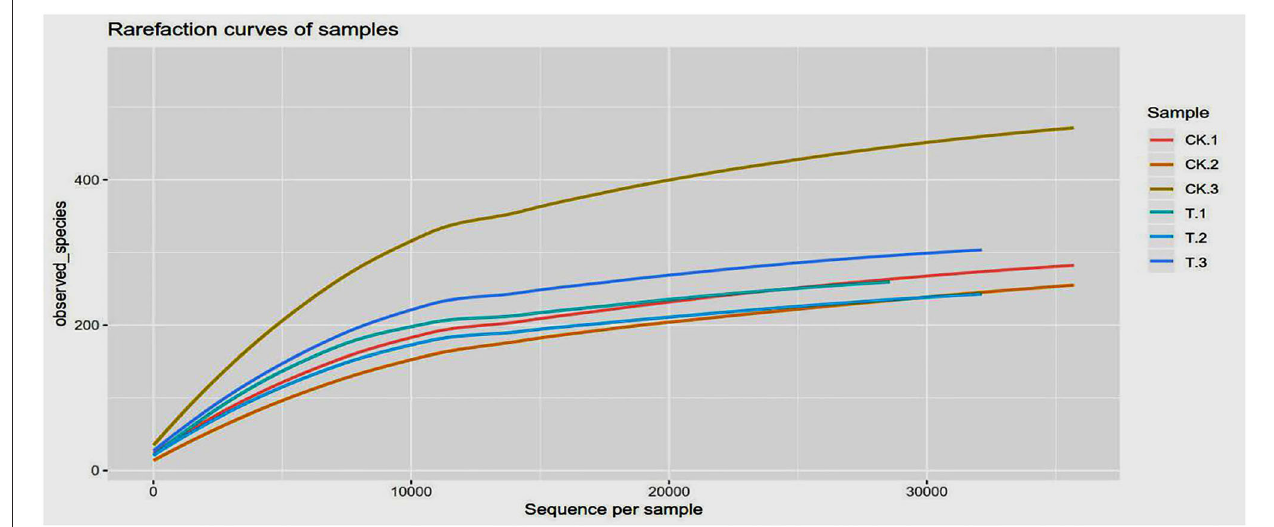
FIGURE 4 | Rarefaction curves based on observed species value. The rarefaction curve was plotted where the X-axis represents the number of clones (sequences) and the Y-axis represents the number of observed species (CK, SBM; T, FSBM).